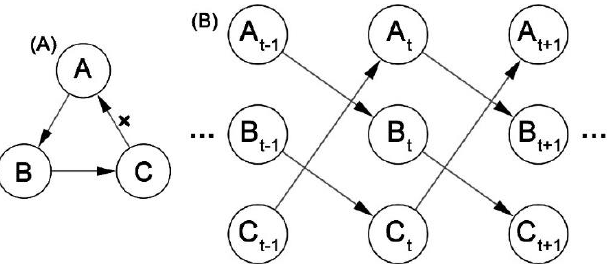
Figure 3. Example of a static Bayesian network ( A ) and a dynamic Bayesian network ( B ) .